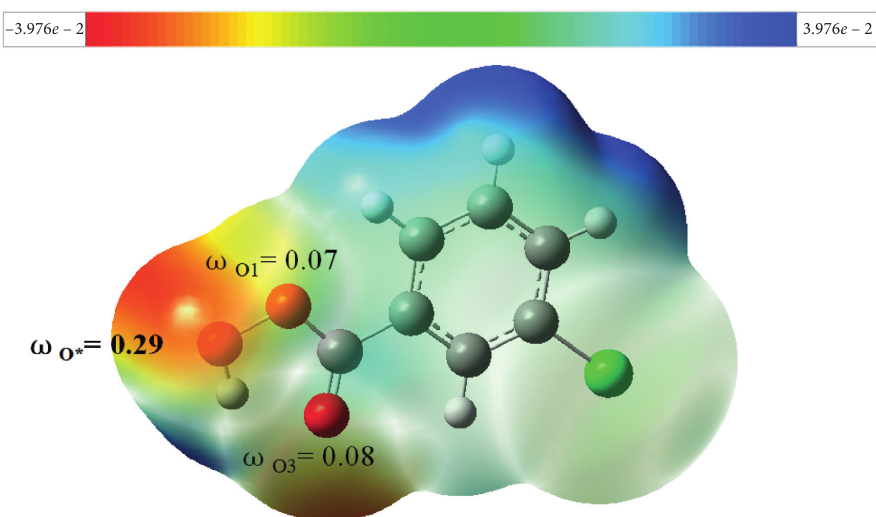
Figure 2: The density map and electrophilicity index of m-CPBA.